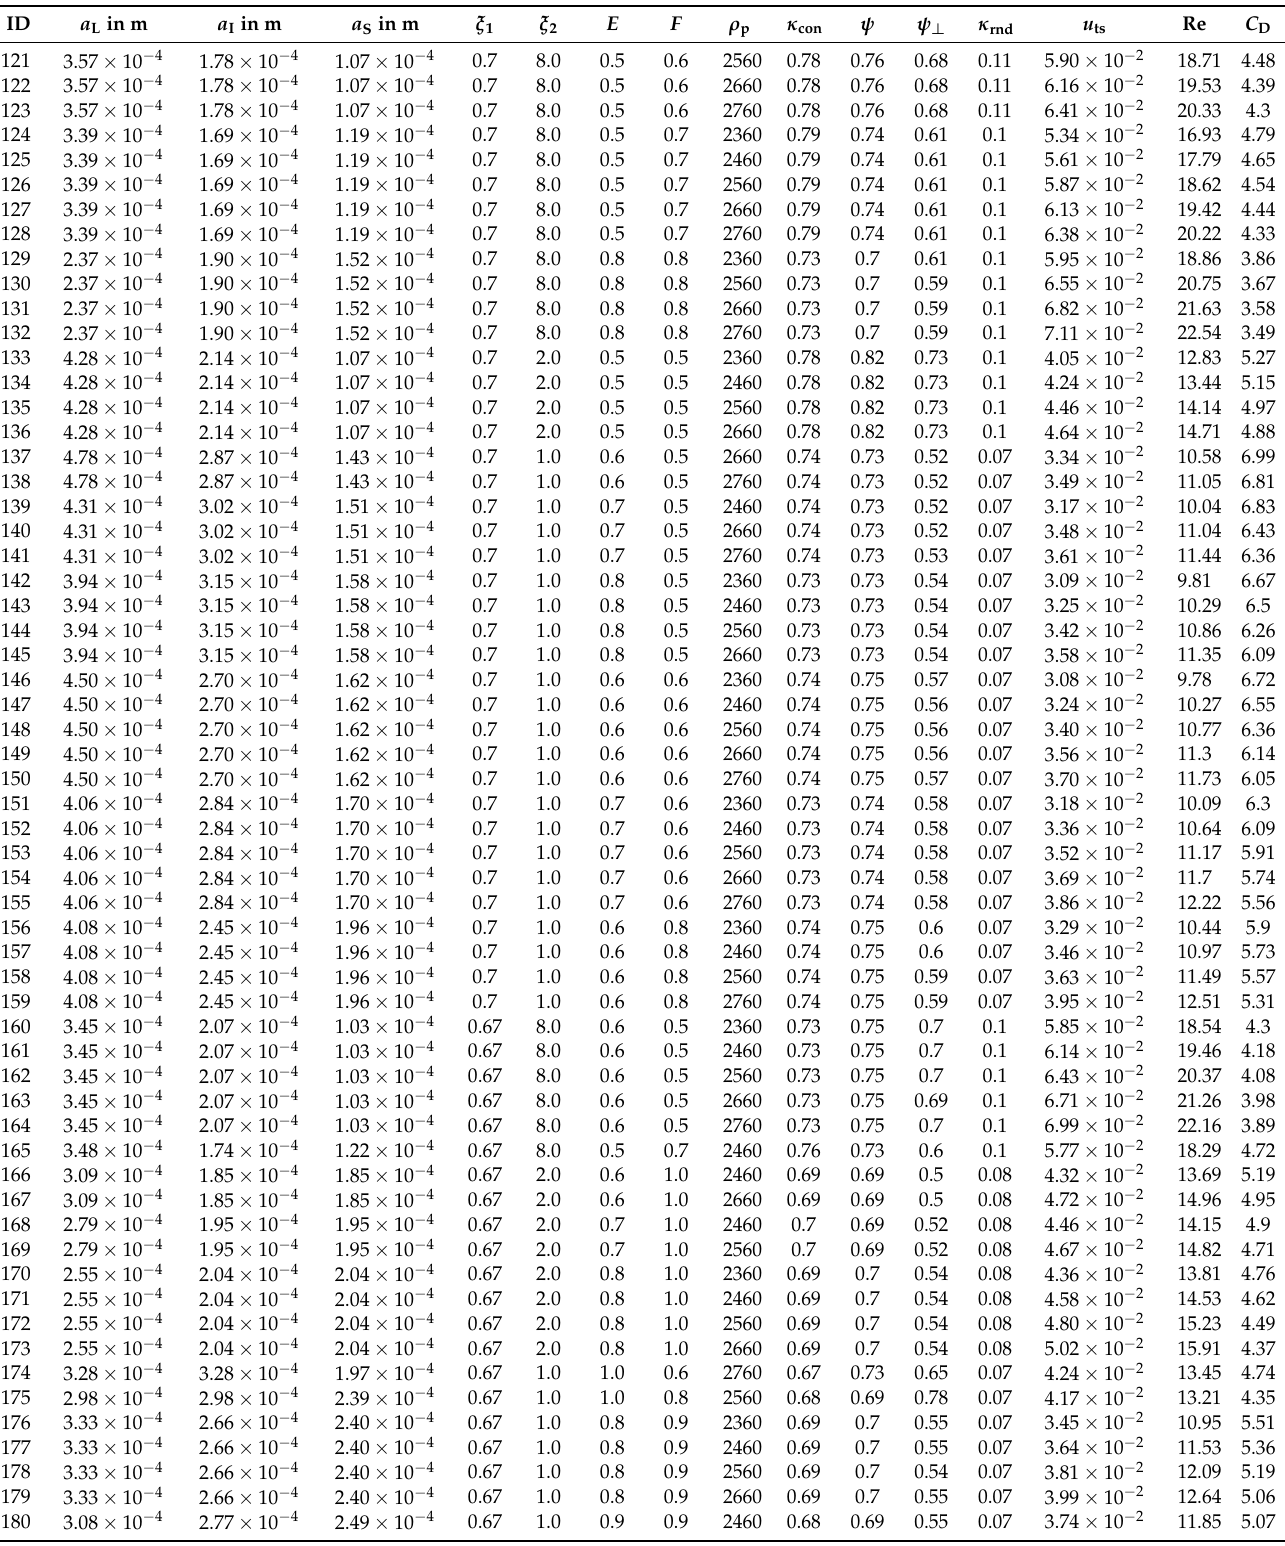
Table A3. Data of the particles in the training